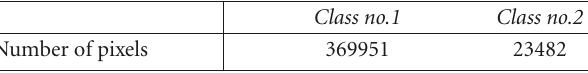
Table 3: Number of pixels in each class.